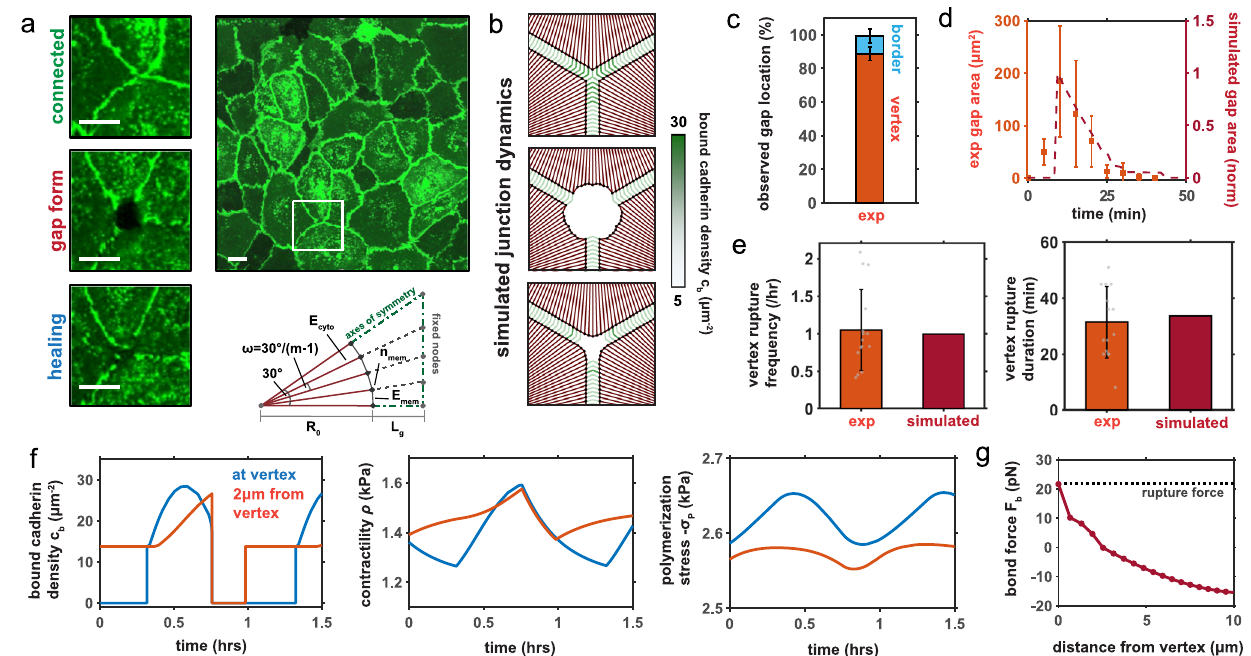
Fig.4|SimulationsofJunctionDynamicsatCellVertices.a Dynamicbehaviorof HUVECs expressing VE-cadherin-GFP cultured on a thin collagen gel, showing typical formation and healing of gaps at a multi-cell vertex. Inset frames recorded at 0min, 70min, and 130min (top to bottom). Scale bar: 20 μ m ; ( b ) Sample gap formation and healing within the simulated monolayer; ( c ) Experimentally observed gap locations in the HUVEC monolayer with rupture predominantly occurringatmulticellvertices(mean s.d., n =15gaps);( d )Measuredandsimulated